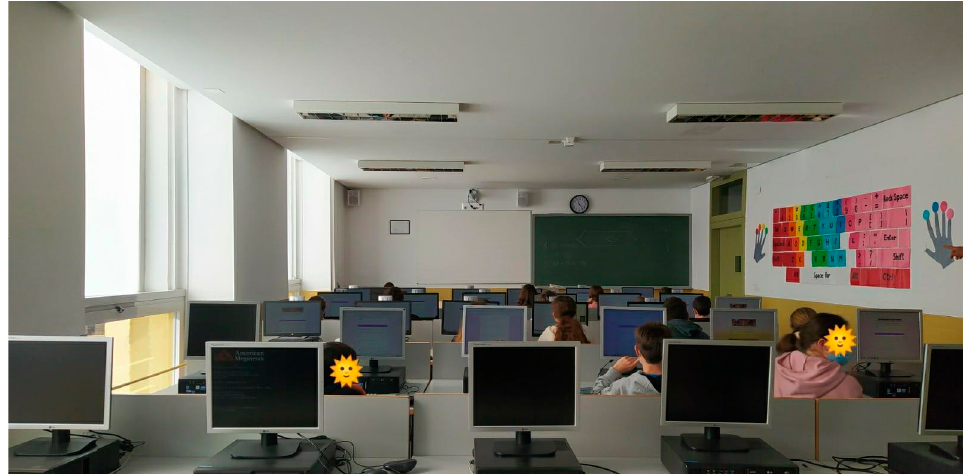
Figure 1. This is a figure. Schemes follow the same formatting. Figure 1. Providing the students with an initial questionnaire prior to the start of the sessions. Stage 2.